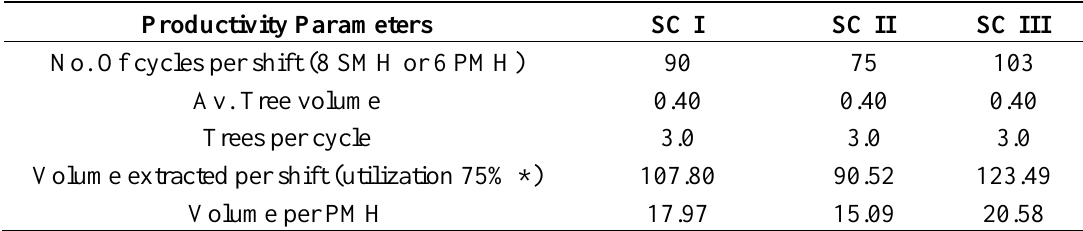
Table 5. The simulation of daily productivity.